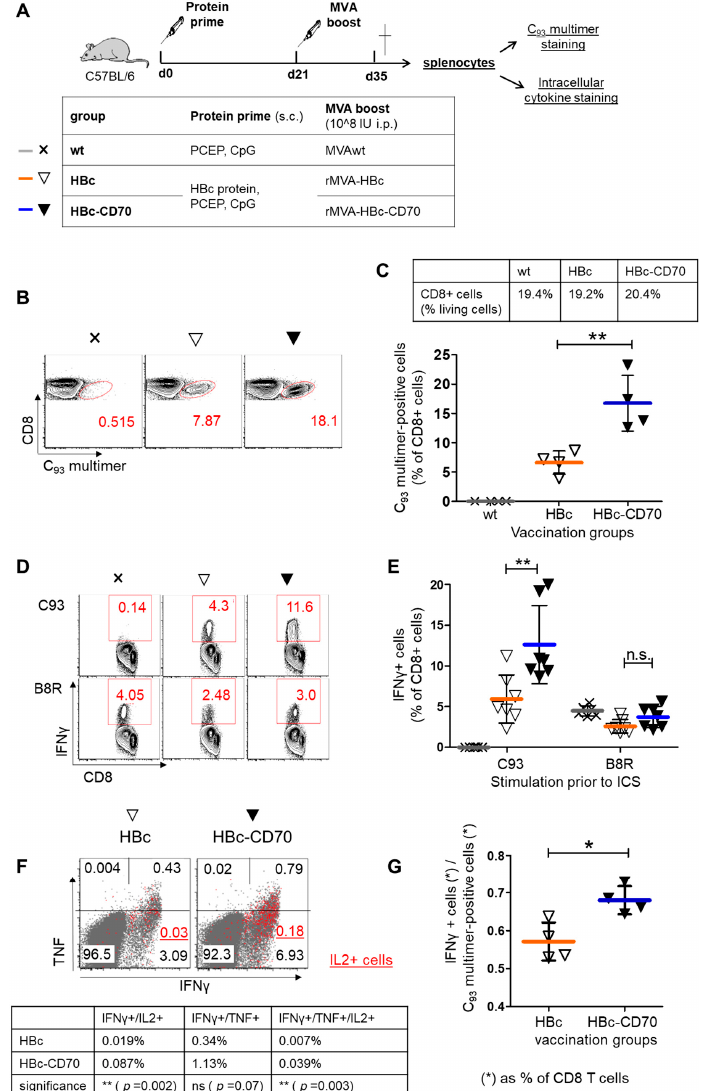
Figure 2. Vaccination of C57Bl/6 mice with rMVA-HBc±CD70. ( A ) C57Bl/6 mice were immunized subcutaneously with HBcAg adjuvanted with CpG and PCEP at day 0 (group wt received adjuvants only). At day 21, mice were boosted with MVAwt (group wt), rMVA-HBc (group HBc) or rMVA- HBc-CD70 (group HBc-CD70) by intraperitoneal injection. At day 35, splenocytes of mice were isolated and stained with PE-labelled C 93 multimers to determine the amount of HBc-specific CD8 T cells ( B ) showing representative dot plots and ( C ) showing the group analysis. The table ( C ) shows the proportion of all CD8+ T cells. At day 35, splenocytes of vaccinated mice were also stimulated ex vivo with C 93 or B8R peptides for intracellular cytokine staining (ICS) to evaluate C 93 - or B8R- specific IFN γ -, TNF α - and IL2 production of CD8 T cells ( D ) showing representative dot plots and ( E ) showing the group analysis. ( F ) Simultaneous detection of IFN γ , TNF α and IL2 production of CD8 cells upon HBc stimulation ex vivo: dot plots show one representative mouse of each group. The table shows the mean values (% of CD8+ cells) of 4 mice/group. ( G ) The gain of function of CD8 T cells after CD70 co-stimulation during vaccination: the proportion of IFN γ + CD8 T cells upon ex vivo C 93 stimulation was set in relation to the proportion of C 93 multimer-positive CD8 T cells in the same animals. Proportions were calculated for each mouse separately. C 93 : HBcAg CD8 T cell epitope; B8R: MVA-derived CD8 T cell epitope. Crosses and triangles represent individual mice; horizontal lines indicate mean values; error bars indicate standard deviation. Statistics: one-way ANOVA and subsequent unpaired t-test, n.s.: not statistically